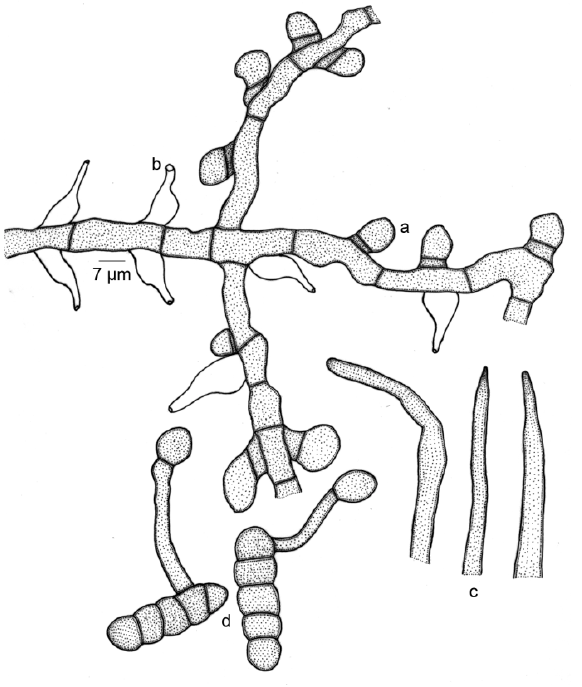
Figure 110. Meliola psophocarpi a - Appressorium; b - Phialide; c - Apical portion of mycelial setae; d - Ascospores